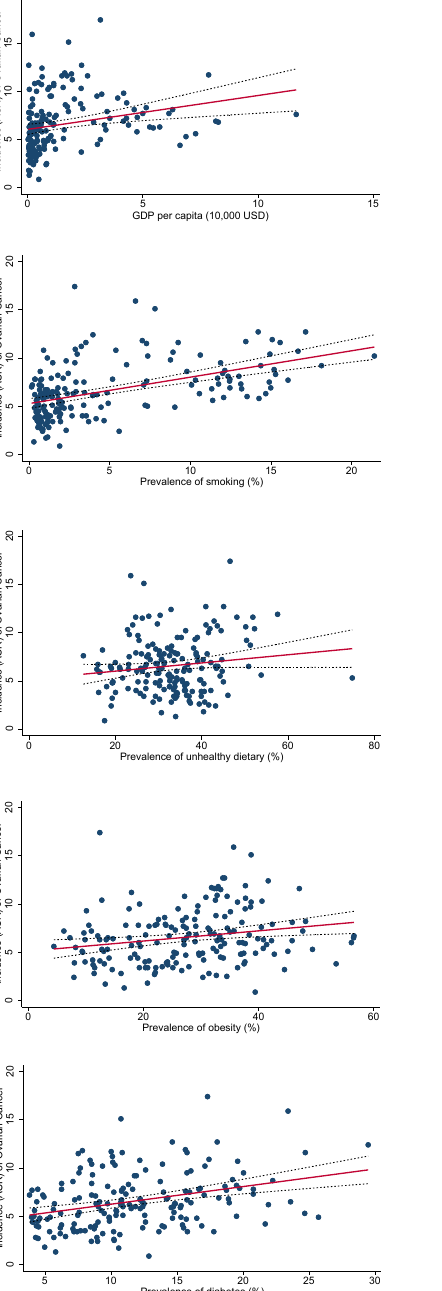
Figure 2. Associations between risk factors and incidence of ovarian cancer